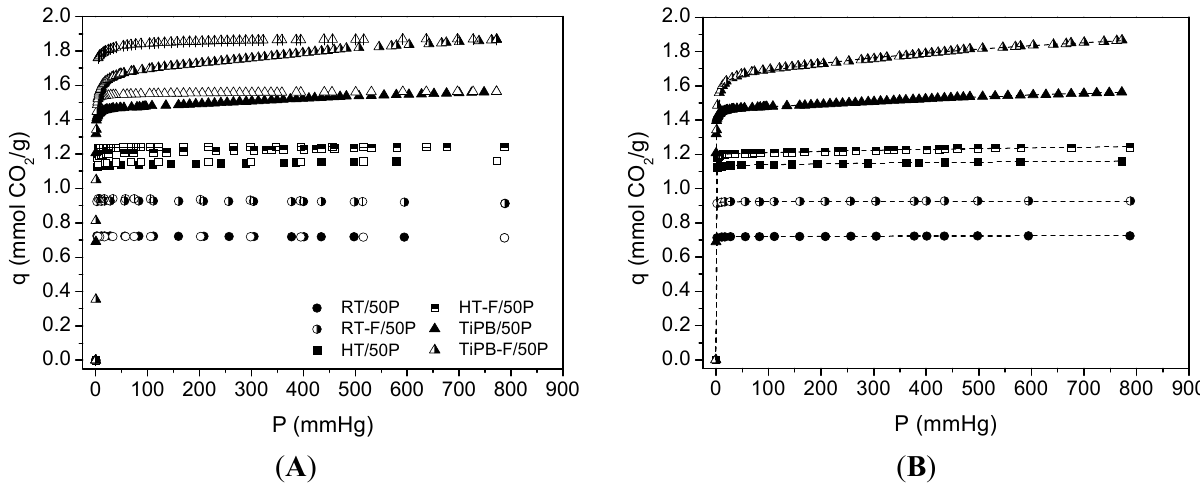
Figure 7. ( A ) CO 2 isotherms at 25 °C on polyethylenimine ethylenediamine branched (PEI)-impregnated silicas Adsorption data are the filled symbols and desorption data are the empty symbols; ( B ) dotted lines are fits from de Dualsite Langmuir model using adsorption